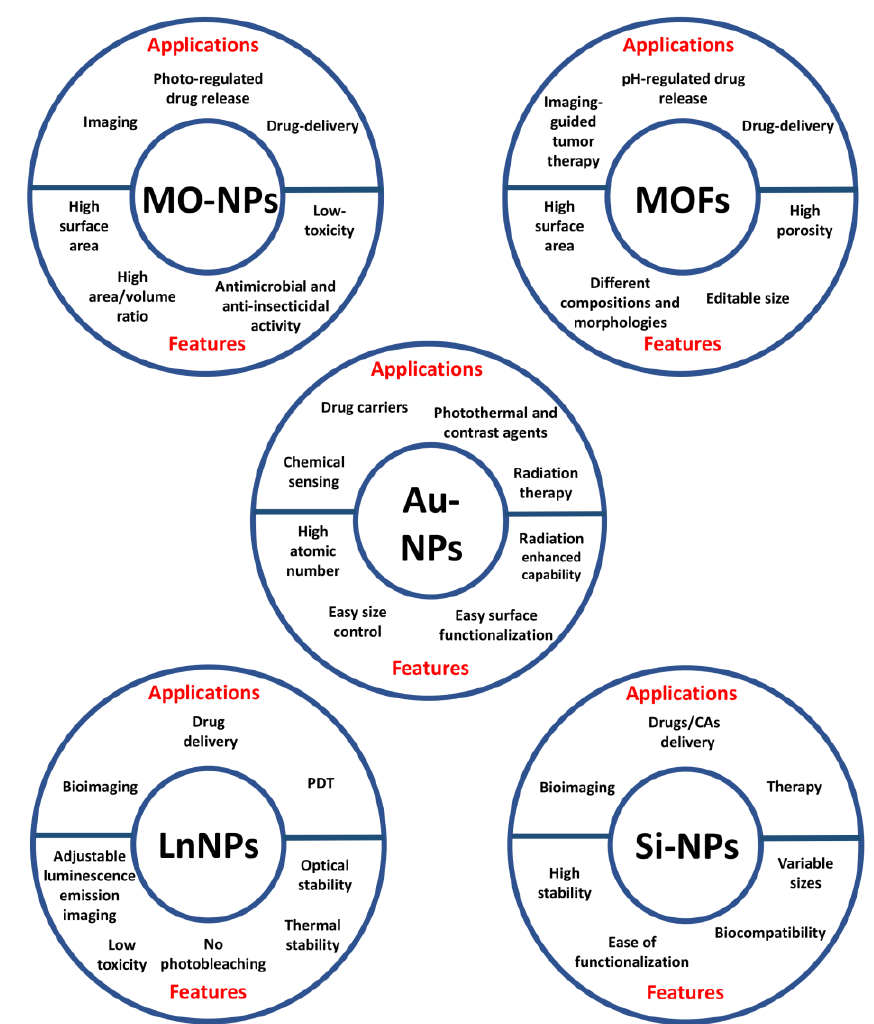
Figure 3. Applications and features of the different types of inorganic nanoparticles .